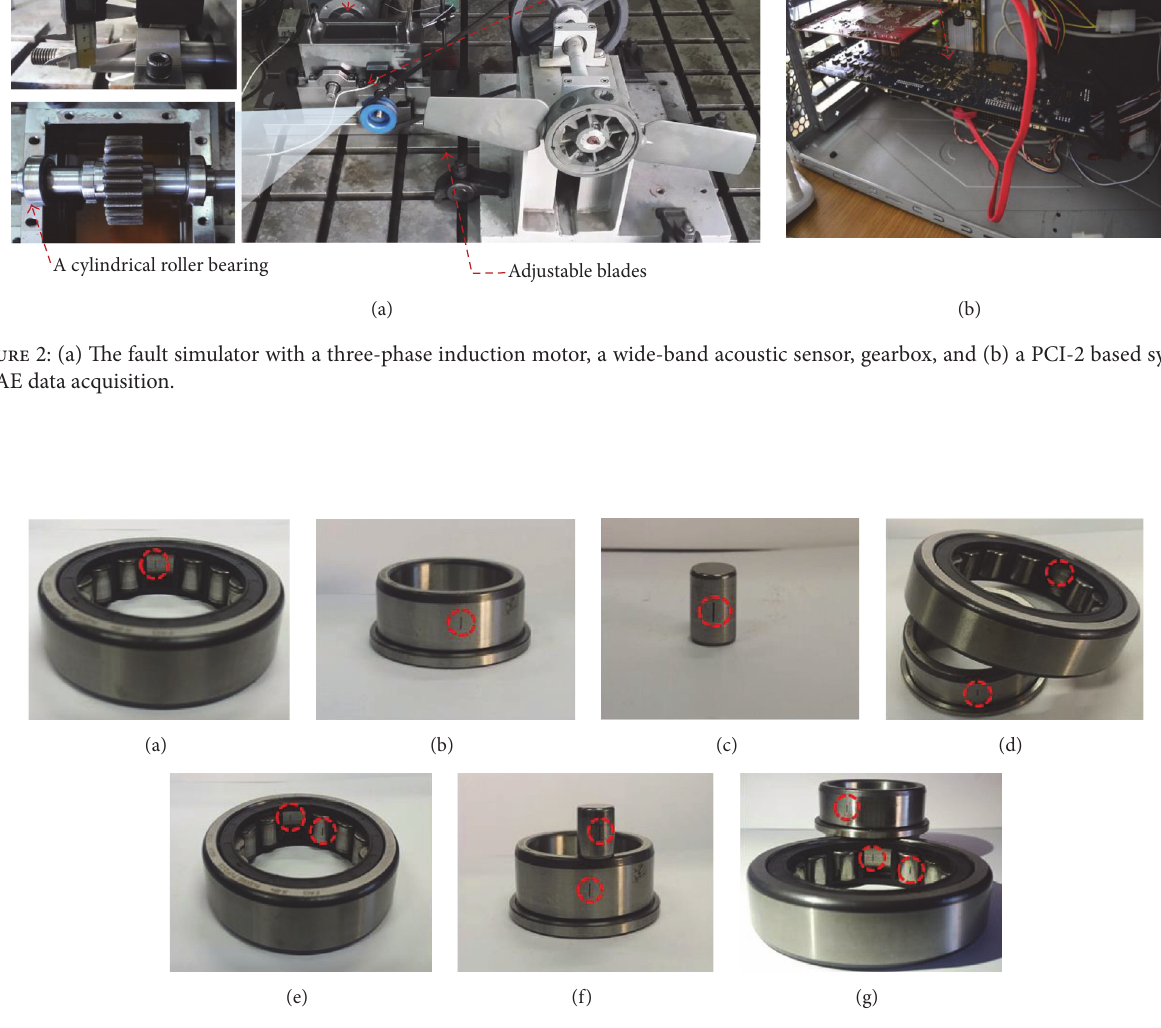
Figure 3: Different single and combined bearing faults: (a) outer raceway fault, (b) inner raceway fault, (c) roller fault, (d) outer and inner raceway faults, (e) outer raceway and roller faults, (f) inner raceway and roller faults, and (g) inner and outer raceway and roller faults.